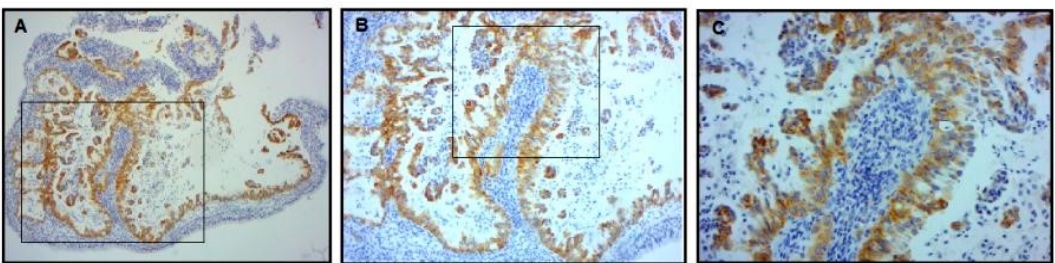
Figure 6. Anaplastic lymphoma kinase (ALK) protein expression: Tumor harboring positive ALK Figure 6. Anaplastic lymphoma kinase ( ALK) protein expression: Tumor harboring positive ALK expression shows strong granular and homogenous cytoplasmic staining, ( A ) 100 × , ( B ) 250 × , ( C ) 400 × expression shows strong granular and homogenous cytoplasmic staining, ( A ) 100×, ( B ) 250×, ( C ) 400×. Figure 6. Anaplastic lymphoma kinase ( ALK) protein expression: Tumor harboring positive ALK expression shows strong granular and homogenous cytoplasmic staining, ( A ) 100×, ( B ) 250×, ( C ) 400×. Figure 6. Anaplastic lymphoma kinase ( ALK) protein expression: Tumor harboring positive ALK expression shows strong granular and homogenous cytoplasmic staining, ( A ) 100×, ( B ) 250×, ( C ) 400×.